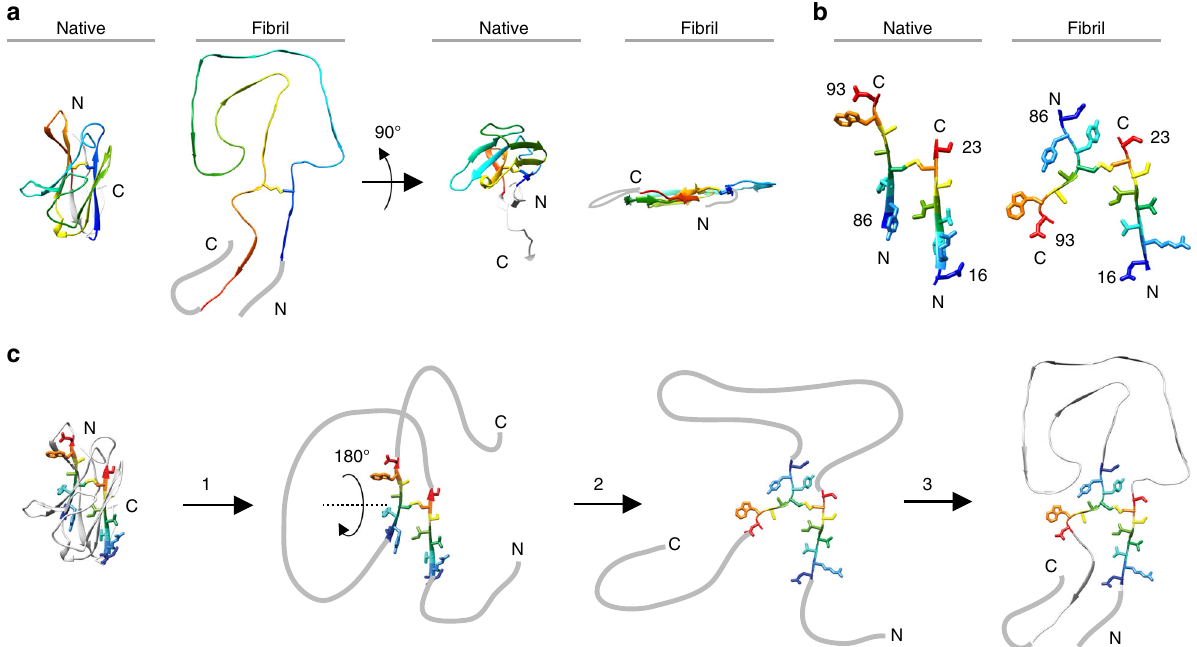
Fig. 4 Comparison of the fi bril structure and the native V L domain fold. a Comparison of the native V L domain fold (PDB entry 1BJM) 60 with the fi bril state. Residues 15 – 105 are shown in rainbow color. The native conformation is truncated at residue 118, corresponding to our fi bril protein. The diffuse N-terminal and C-terminal tails of the fi bril structure are schematically added with a gray line. b Part of the native structure and of the fi bril state showing the conformational switch of segments 86 – 93 and 16 – 23 relative to one another around the protein disul fi de bond. c Schematic representation of the hypothetical misfolding reaction consisting of an unfolding reaction (1), the rotational switch (2) and the assembly into the fi bril structure